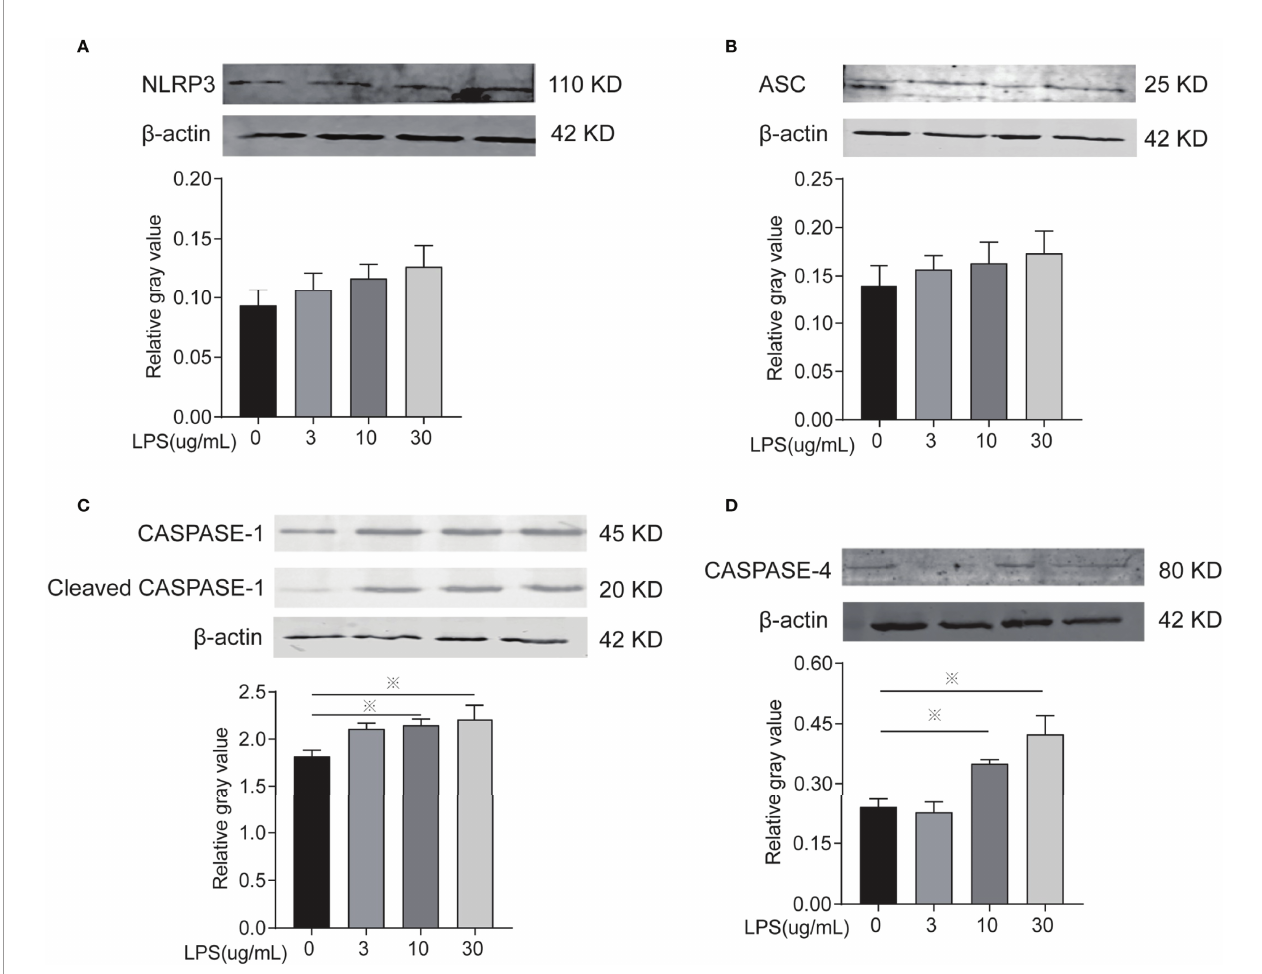
FIGURE 5 | In fl ammasomes protein expression of cells treated with different concentrations of LPS for 24 h. (A) Protein electrophoresis, (B) NLRP3, (C) ASC, (D) CASPASE-1, and (E) CASPASE-4. Each treatment had three samples (n = 3) and was repeated three times to reduce system errors; “ ※ ” means there was a signi fi cant difference ( P < 0.05 ) compared with negative control (LPS, 0